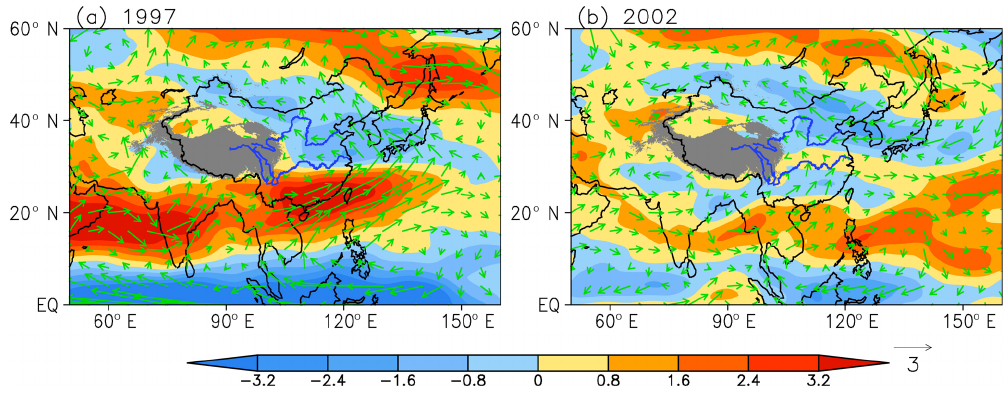
Figure 10. Horizontal distribution of 850 hPa wind anomalies (vectors; ms − 1 ) and divergence (shading; 10 − 5 s − 1 ) at 700hPa during the winters of (a) 1997 and (b) 2002.